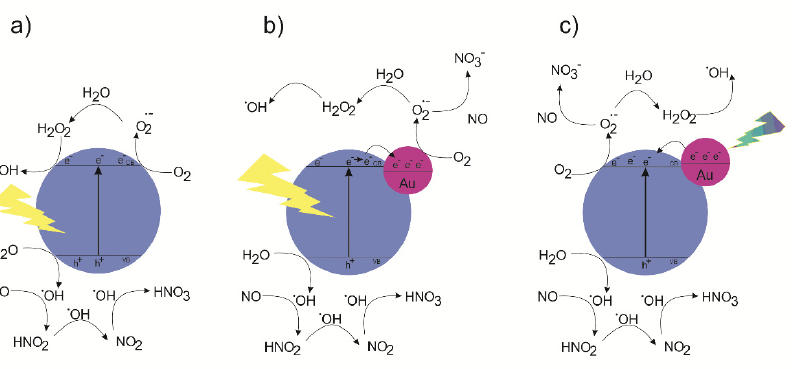
Figure 5. Schematic representation of mechanism of NO photocatalytic oxidation over SG ( a ) and Au0.5 photocatalyst under UV ( b ) and visible light ( c ).